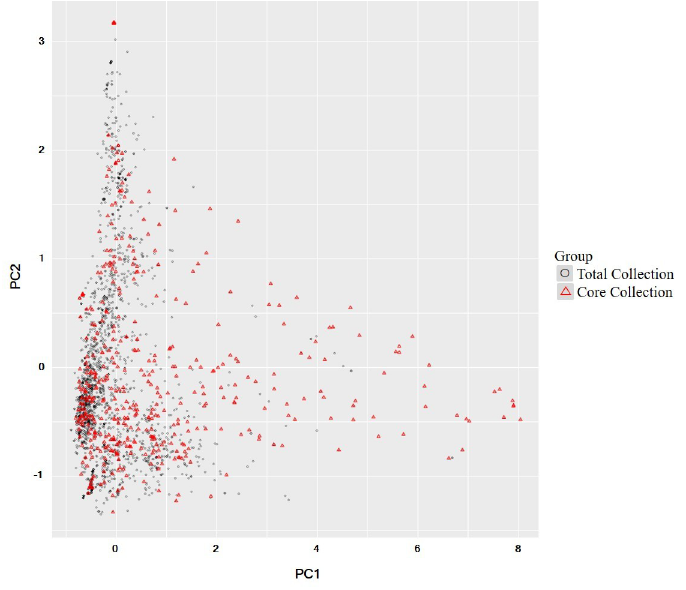
Fig 1. Principal component analysis of the core collection (red triangle) and the total collection (black circle).